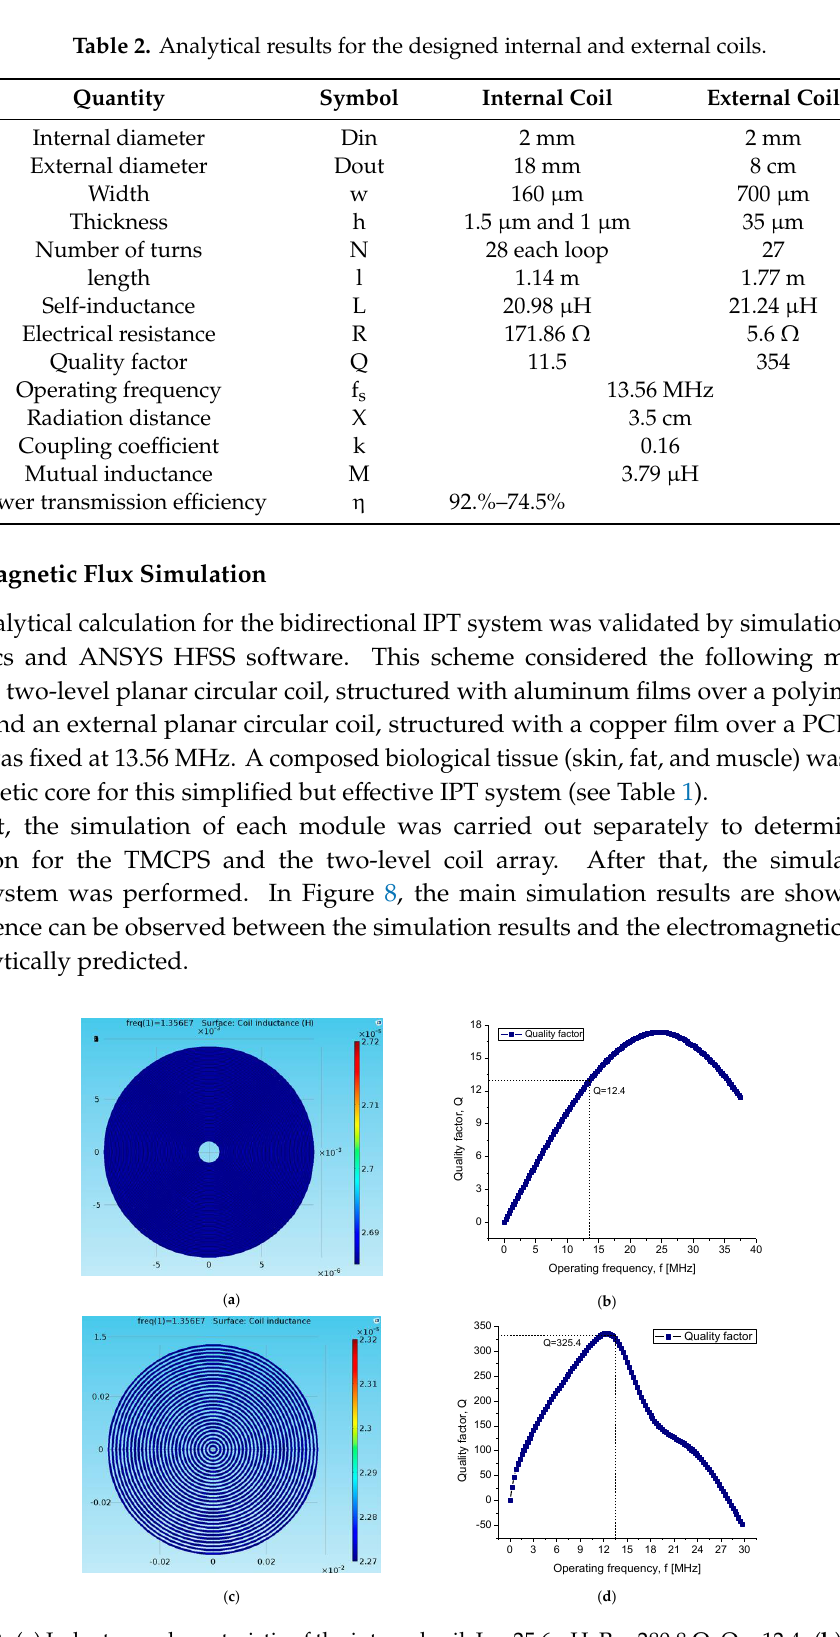
Figure 8. ( a ) Inductance characteristic of the internal coil; L = 25.6 μH, R = 280.8 Ω, Q = 12.4. ( b ) Quality factor of the internal coil, ( c ) inductance of the external coil; L = 20.18 μH, R = 6.61 Ω, Q = 325.4. ( d ) Quality factor of the external coil.